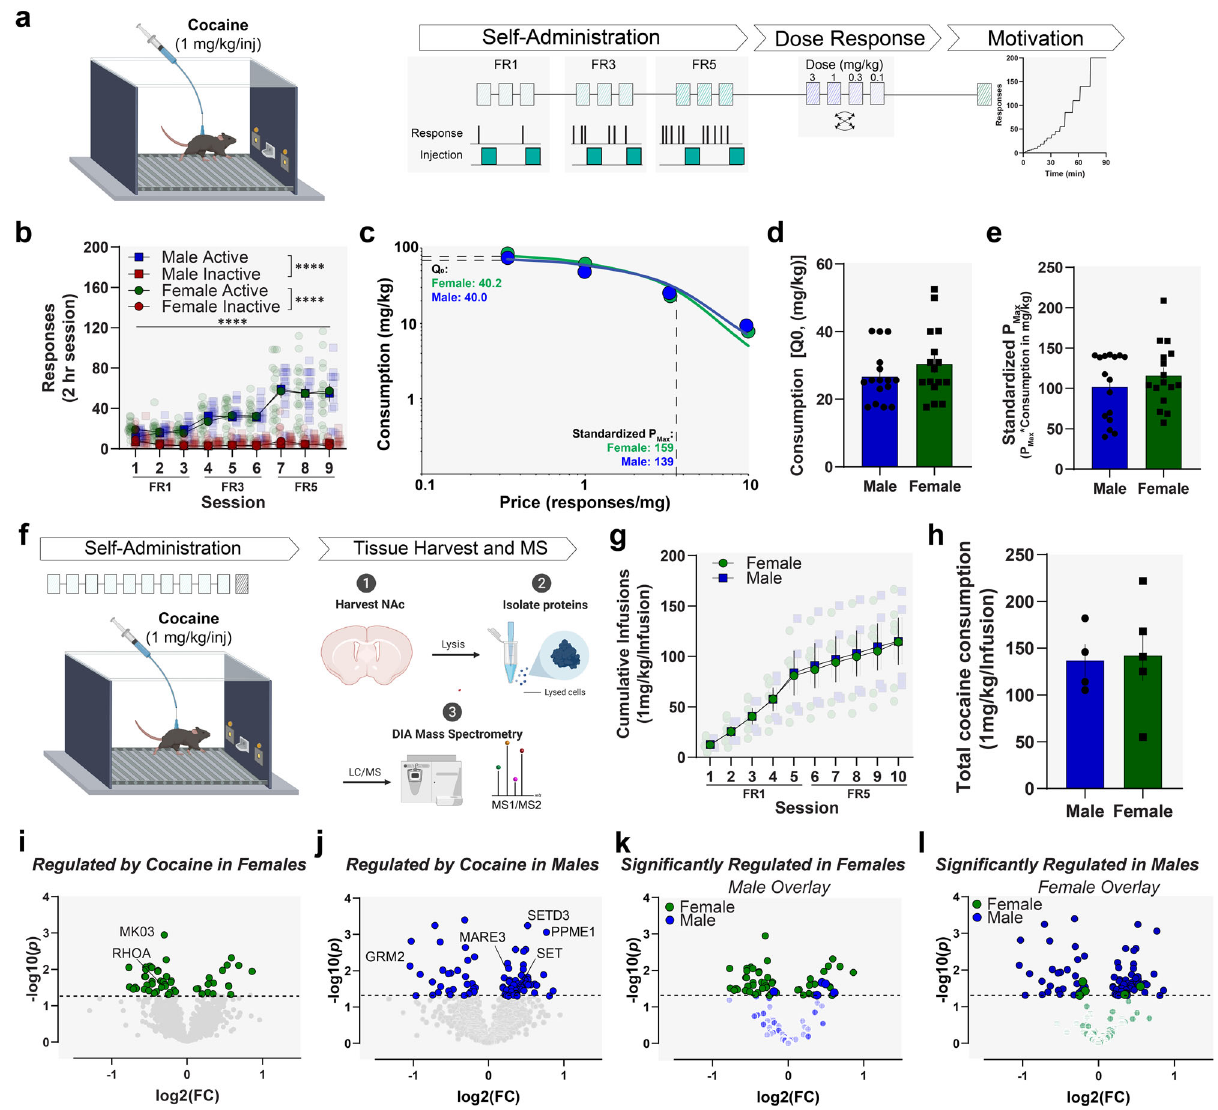
Schematic/timeline of self-administration. b Average responses for cocaine under escalating fi xed ratio schedules in male and female mice. Male and female with doses counterbalanced between animals (0.1, 0.3, 1, and 3mg/kg). Data were plotted as a demand curve where consumption was plotted on the y -axis and and the maximal price paid ( P max ) in males and females. Standardized P max ( Q 0 × P max ) was calculated to allow for comparisons that are not in fl uenced by the between males and females. e Standardized P max was also not signi fi cantly different between males and females. f In a separate group of animals, mice were self-administration, tissue collection, and processing for mass spectrometry. g Male and female mice consumed cocaine at the same rate and h there were